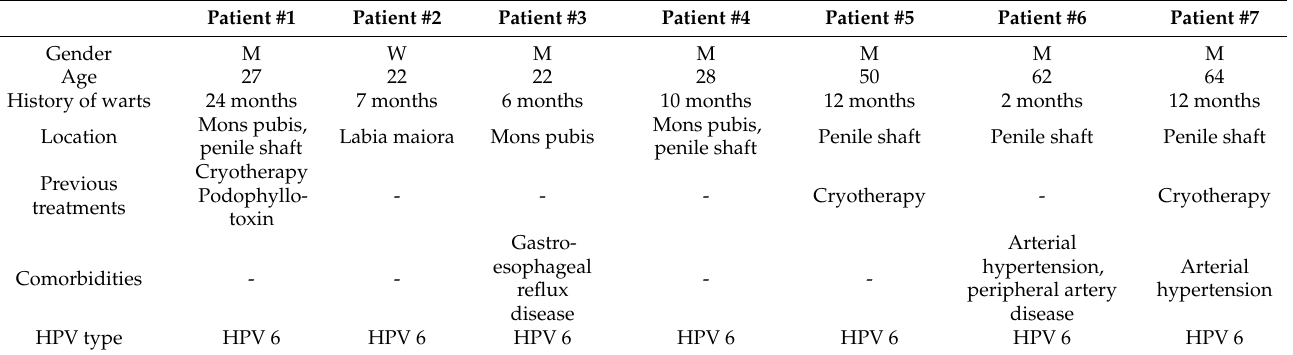
Table 2. Clinical data of the patients with genital